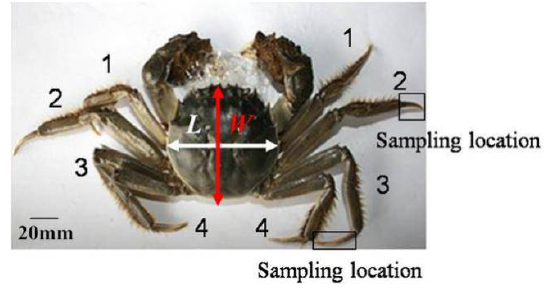
Figure 1. Chinese mitten crab. Table 1. Parameters of Chinese mitten crab specimens.